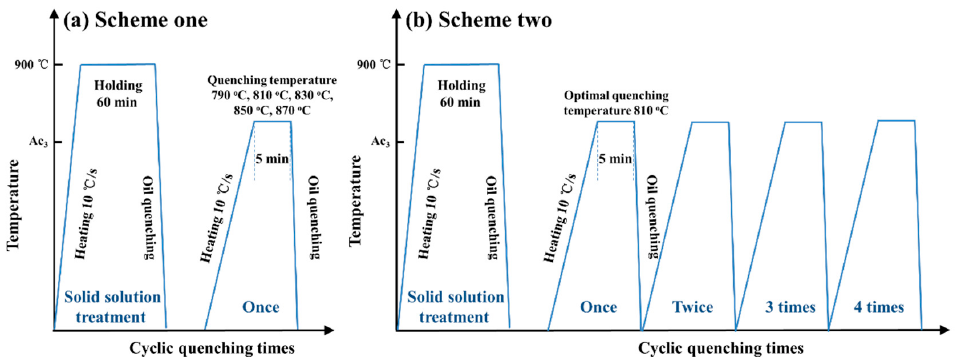
Figure 4. Processing routes for cyclic heat treatment of 65Mn low-alloy steel, ( a ) Scheme one; ( b ) Scheme two. ( b ) Scheme